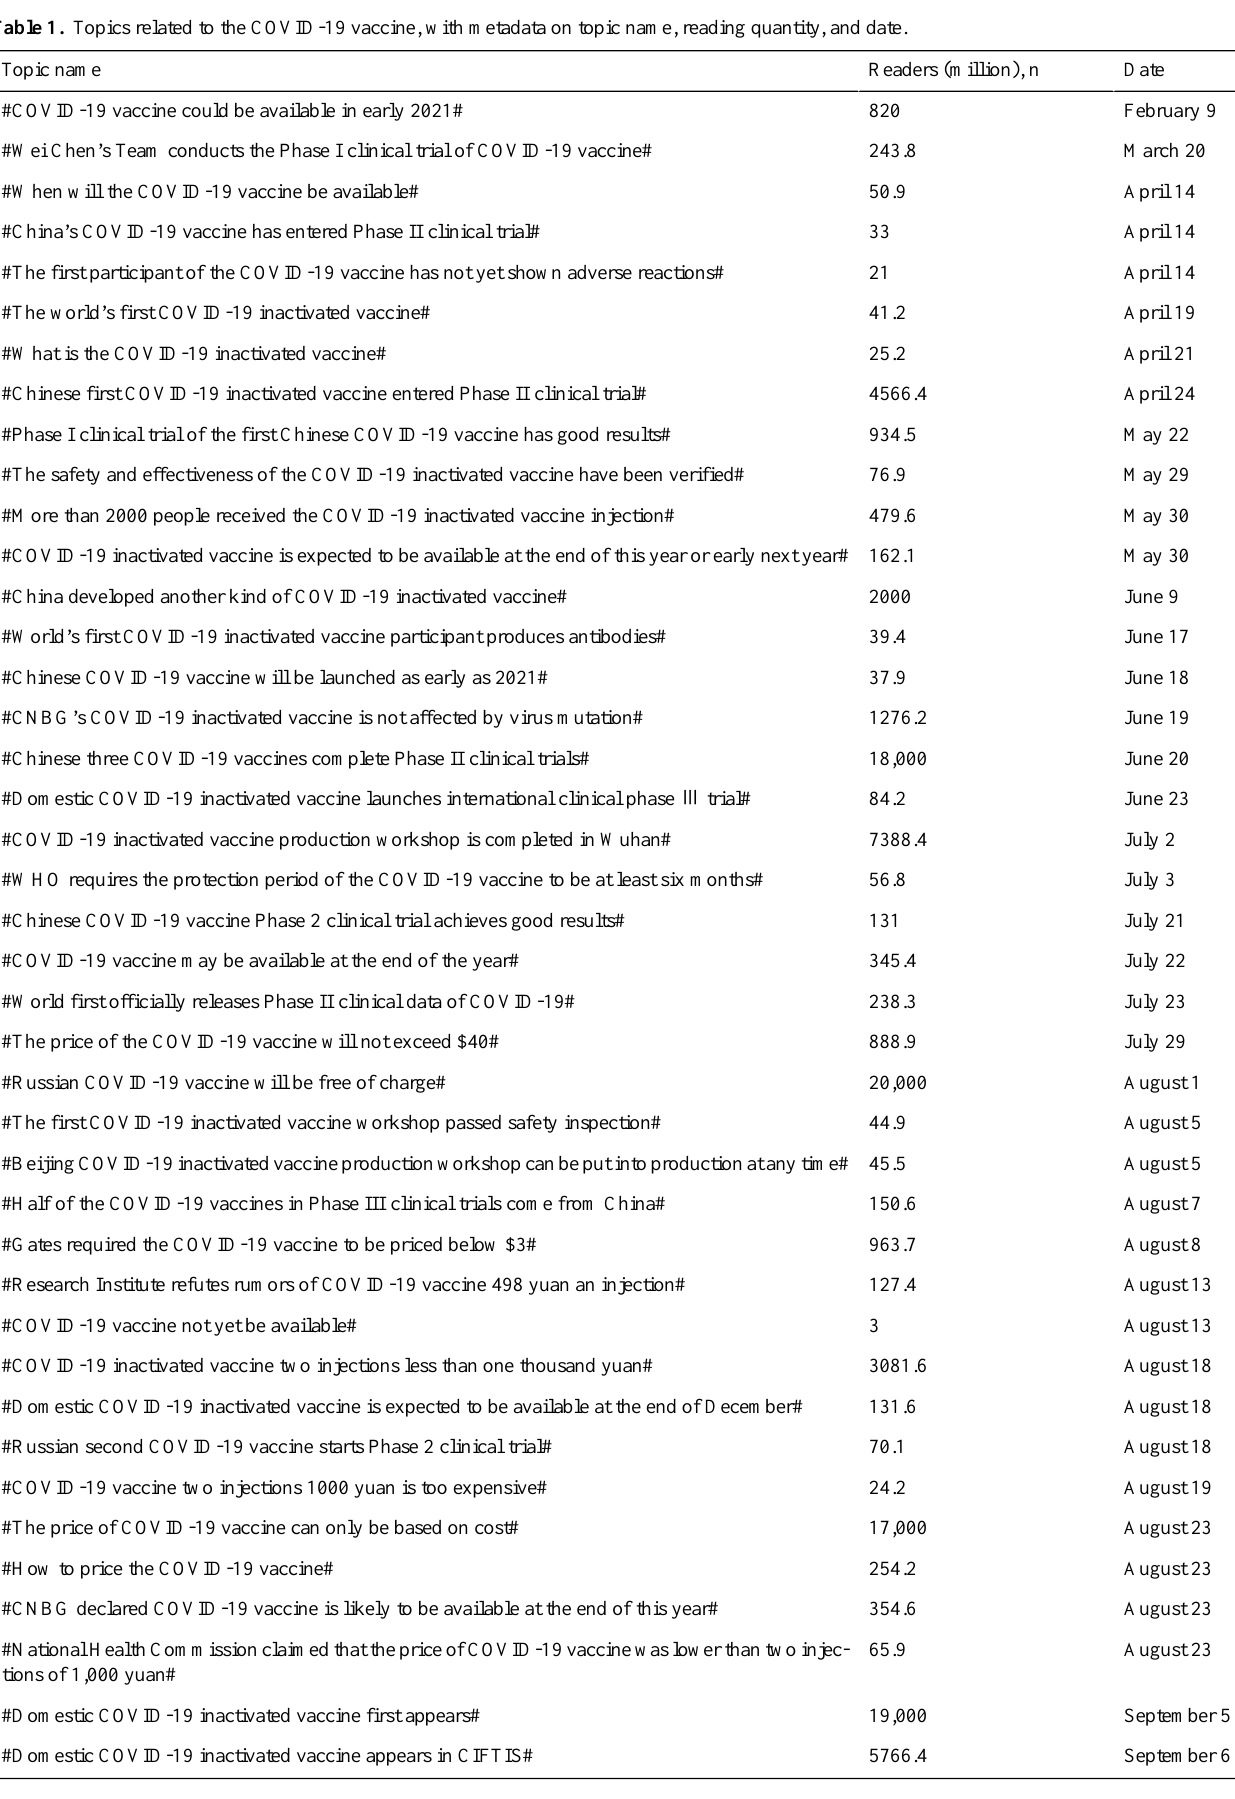
Table 1. Topics related to the COVID-19 vaccine, with metadata on topic name, reading quantity, and